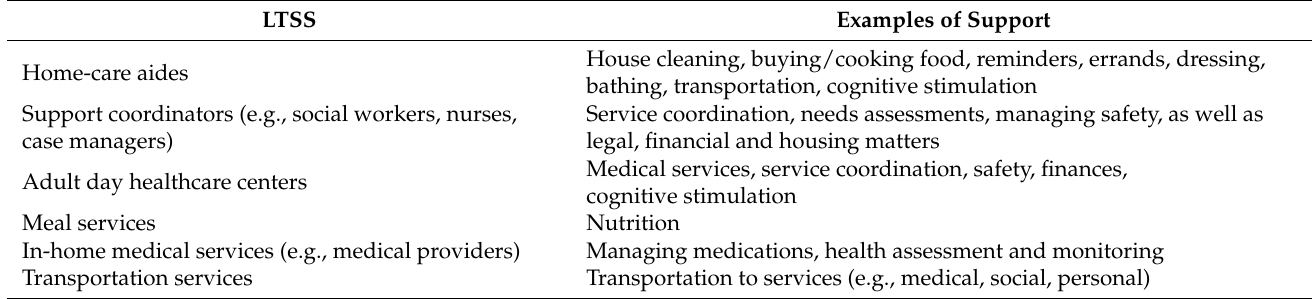
Table 1. Key formal long-term services and support (LTSS) providers for PLACI and examples of